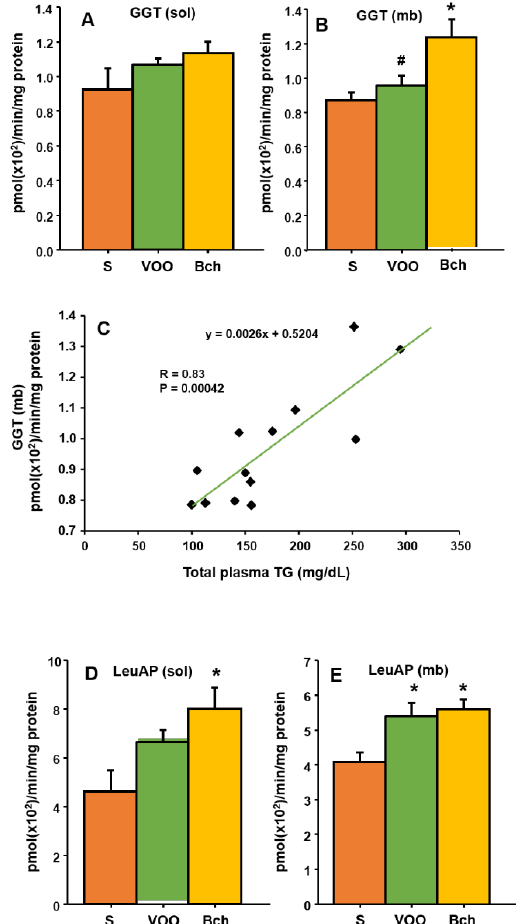
Figure 4. Means values ± standard errors of gamma glutamyl transferase activity (GGT) in liver-soluble ( A ) and membrane-bound ( B ) fractions, expressed as pmol / min / mg prot., linear regressions established between GGT and plasma triglycerides (TG) ( C ); and leucyl aminopeptidase activity (LeuAP) in liver-soluble ( D ) and membrane-bound ( E ) fractions, expressed as pmol / min / mg prot. S: standard diet, VOO: virgin olive oil diet, Bch: butter plus cholesterol diet. * indicates significant di ff erences between VOO or Bch vs. S, * p < 0.05. # indicates significant di ff erences between VOO and Bch, # p <